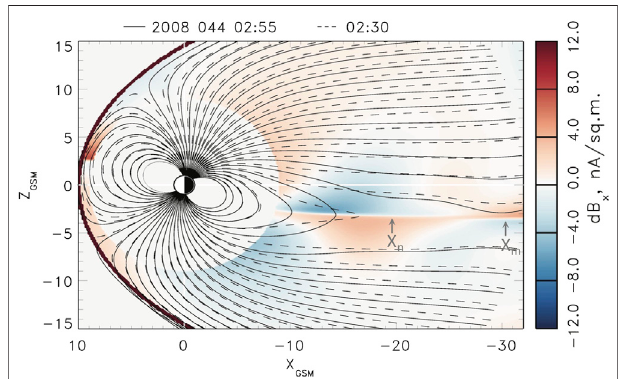
FIGURE 3 | Color-coded variations of the x-component of the magnetic fi eld between moments t (cid:1) 02 : 30 UT and t (cid:1) 02 : 55 UT dB (cid:1) B ( t ) − 0 2 x x 2 B x ( t 0 ) in the noon-midnight meridional plane with overplotted magnetic fi eld lines(solidlinesforthemoment t 2 anddashedlinesforthemoment t 0 )for the 13 February 2008 substorm. The approximate location of the X-lines X n and X m is marked by gray arrows. Magnetic fi eld lines start from the ionosphere at 60 + with 2 + step in latitude. White disks 1 R E < r < 9 R E in panels (B) and (C) mask magnetic fi eld variations in the inner magnetosphere.